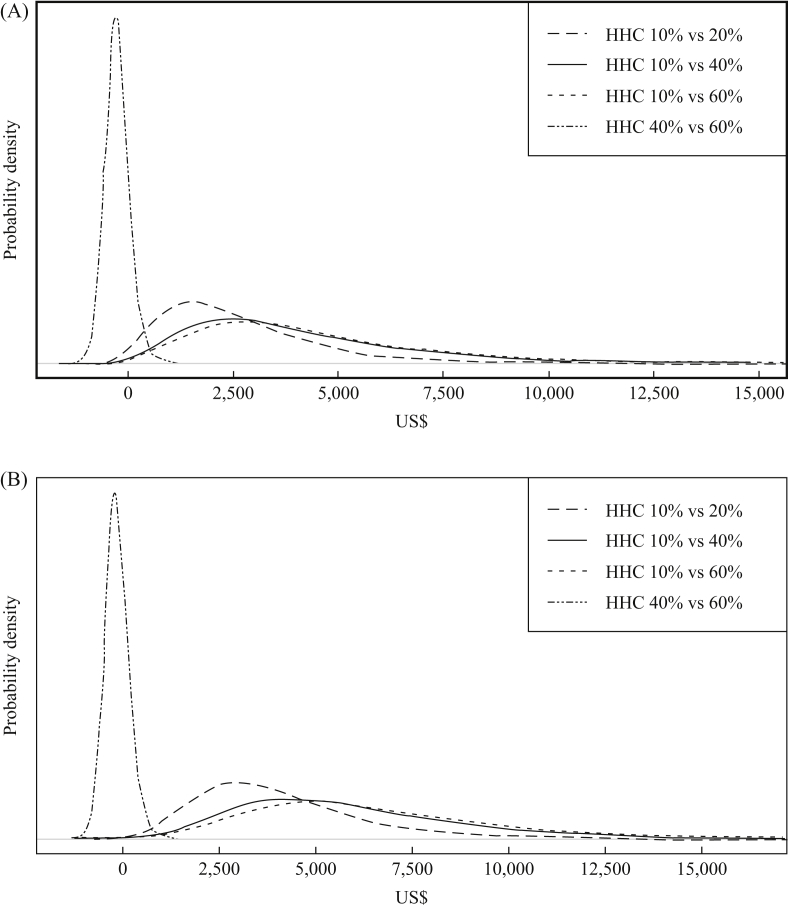
Base case and scenario analyses plotting probability density of incremental net monetary benefits for hand hygiene intervention across four different hand hygiene compliance (HHC) scenarios (baseline compliance at 10% compared with post intervention at 20%, 40% and 60% and baseline compliance at 40% compared with post intervention at 60%) at willingness to pay per quality-adjusted life-year gained of US$4848 for paediatric intensive care unit (A) and adult intensive care unit (B).